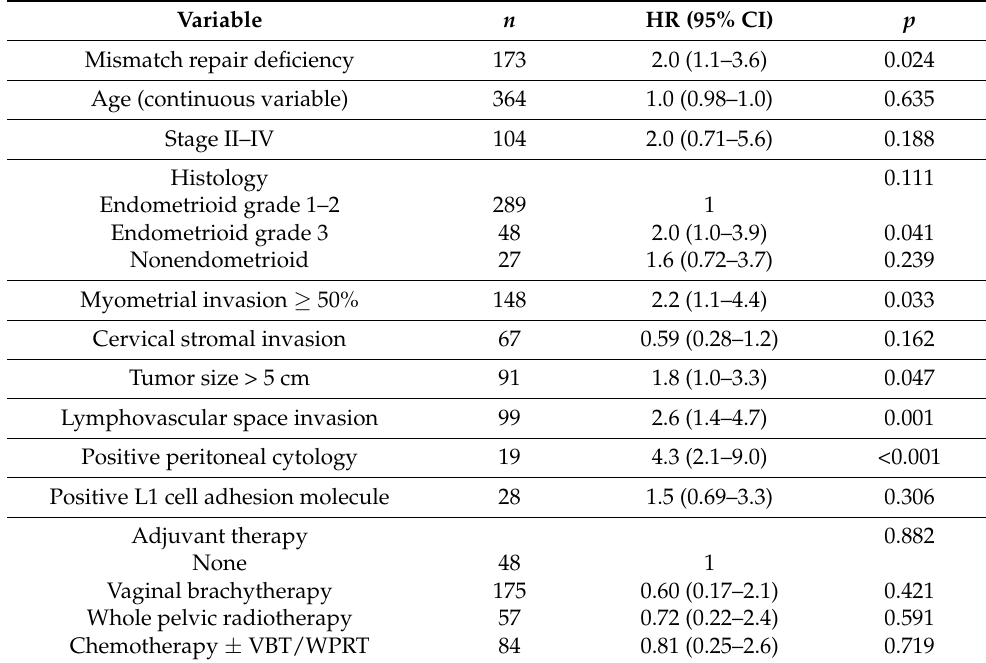
Table 3. Multivariable Cox regression disease-specific survival analysis ( n = 364).